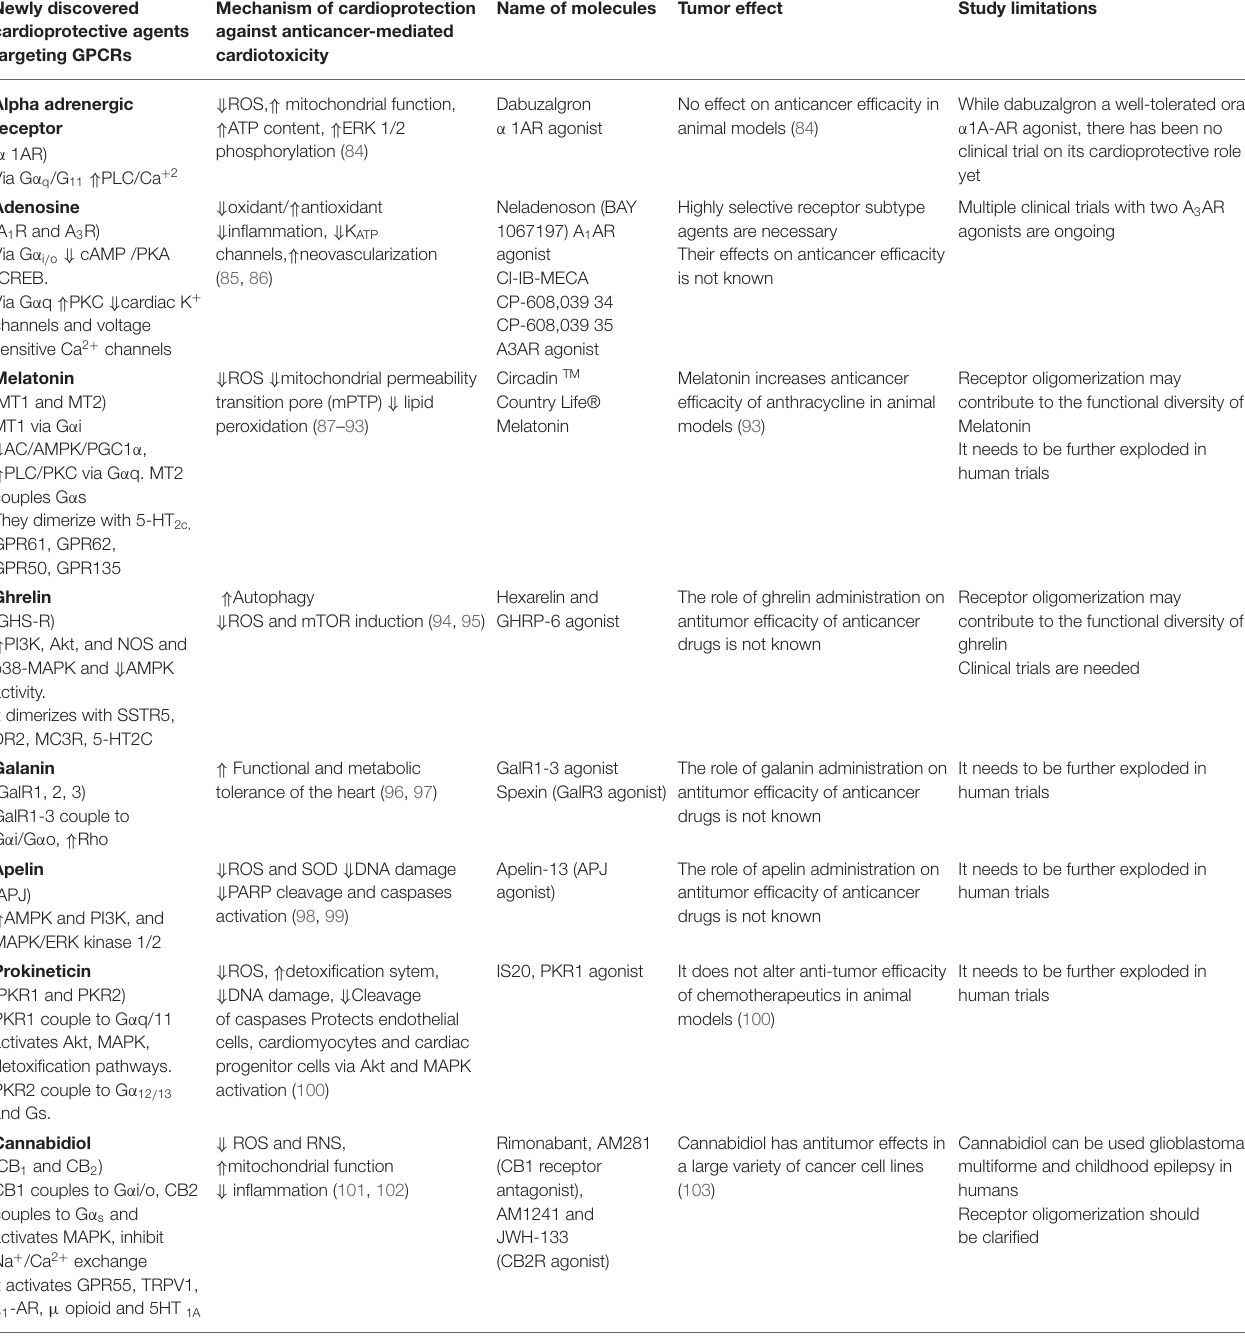
TABLE 2 | Newly discovered cardioprotective agents targeting